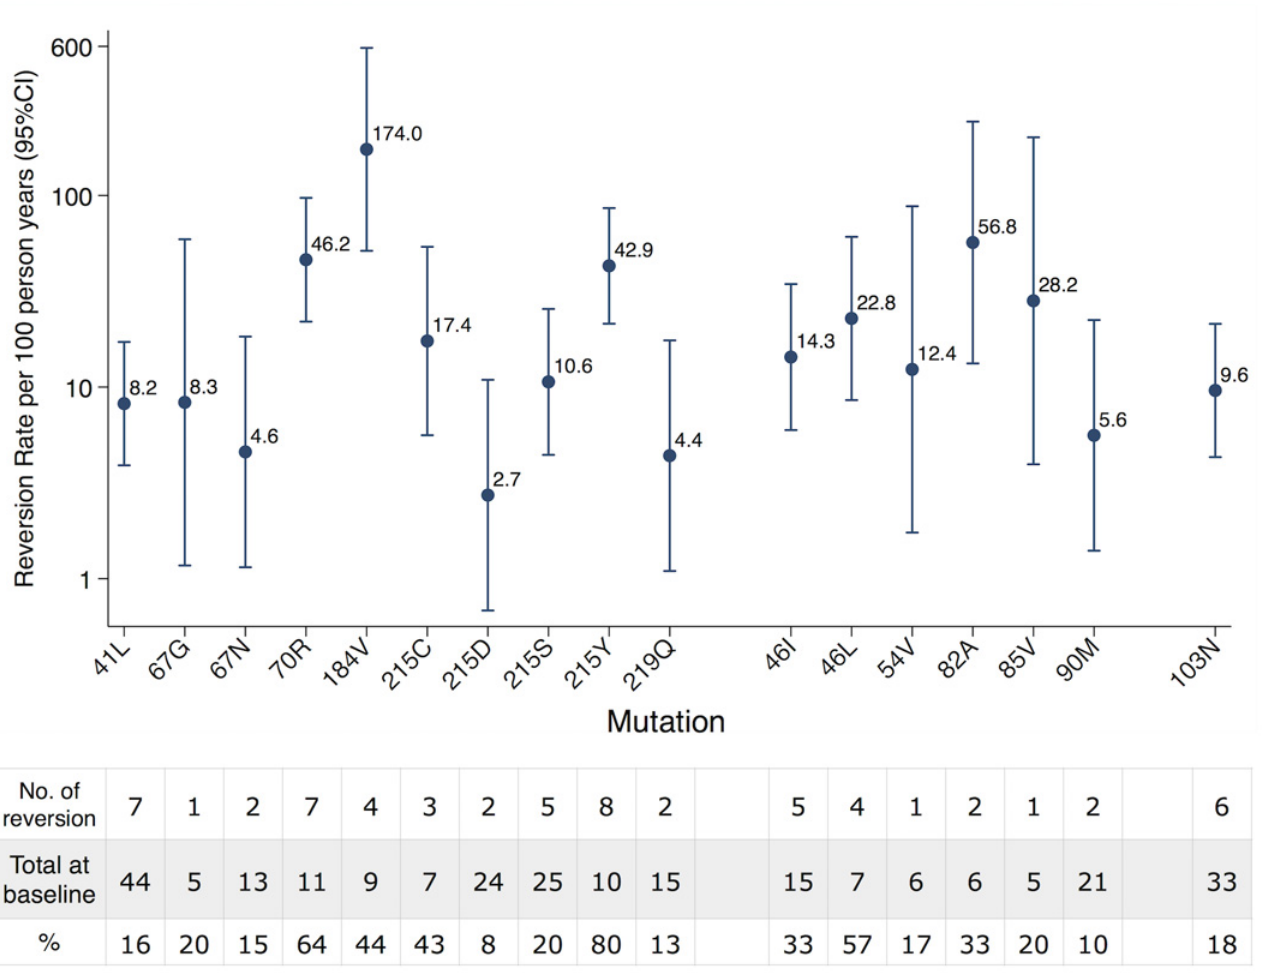
Fig 1. Reversion rate of individual TDRM. Reversion rate was quantified via an interval-censored survival model using an exponential distribution. The table below showed the number of reversion and total number observed at baseline for each TDRM. NRTI resistance mutations showed the largest variability that included both the fastest (184V) and the slowest (215D) reverting TDRM.